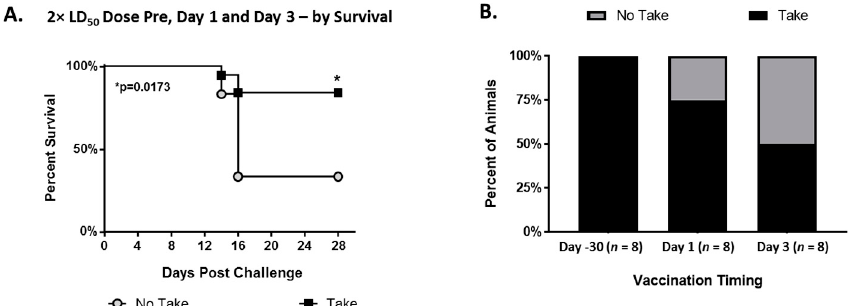
Figure 8. Jennerian pustule “takes”. Kaplan–Meier survival curves for animals from previous and current studies challenged with 2× LD 50 dose of monkeypox virus and vaccinated with ACAM2000 ® or Dryvax ® either 30 days prior to challenge or 1 or 3 days postexposure ( A ) and which manifested a take at the vaccine site (black squares) or did not (gray circles). Survival was significantly higher for animals who manifested a take by log-rank (Mantel–Cox) test (* p > 0.05). Comparison of multiple studies with animals challenged with 2× LD 50 dose of monkeypox virus and vaccinated with ACAM2000 ® or Dryvax ® at Day − 30 pre-exposure, 1 day postexposure, or 3 days postexposure ( B ), showing percentage of animals that manifested a take (brown) or did not manifest a take (black).